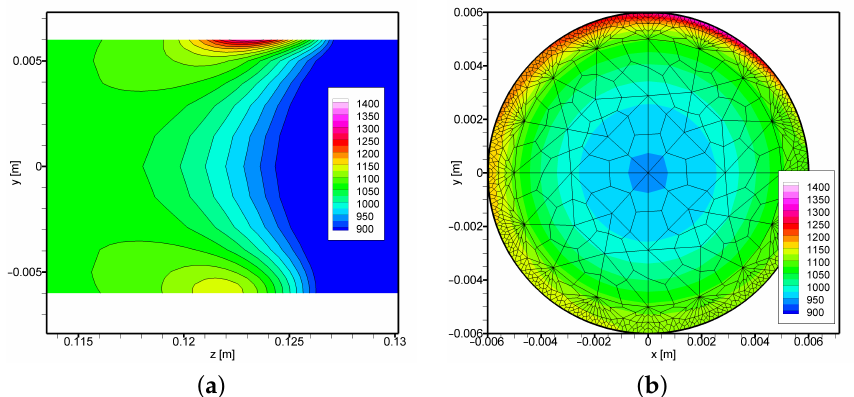
Figure 8. Temperature field in the cross-section: ( a ) longitudinal (x = 0 m), ( b ) transverse (z = 0.1235 m), in the area of maximum temperature ( t = 100 s, I = 80 A, ω p = 2 rot/s).